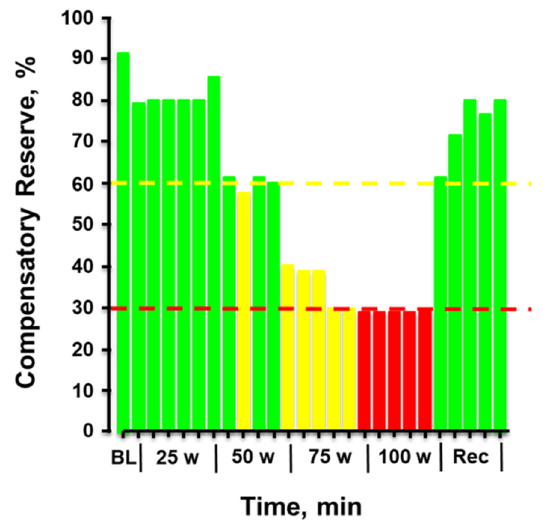
Figure 8. Compensatory reserve measured in a human subject during a 20-min graded cycle ergom- eter exercise performed at 100 ° F air temperature. Each bar represents the average response over 1 min. Bar colors: green, compensatory reserve >60%; yellow, compensatory reserve ≤ 60% and >30%; red, compensatory reserve ≤ 30%. BL, baseline; W, watts. Image modified from [52].